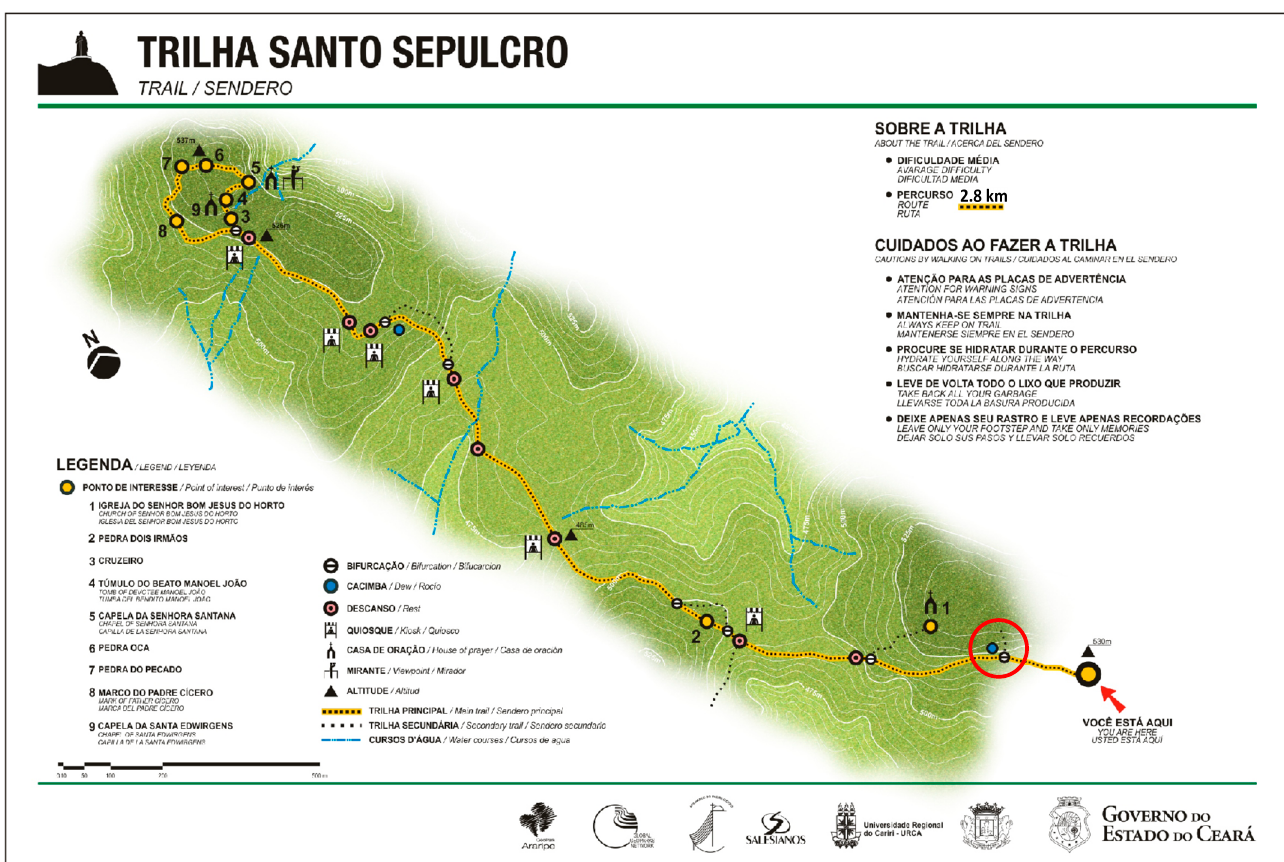
Figure 3. Santo Sepulcro Trail in Colina do Horto Geosite. Highlight in red circle: Official start of the trail at the first bifurcation. Source: Trail Signaling Plan Araripe UGG [52], adapted for the study.